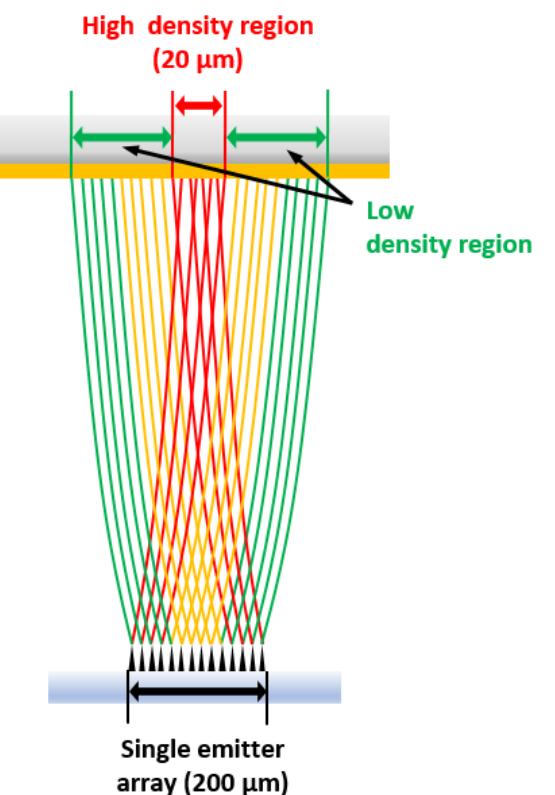
Figure 9. SEM image of Si wafer etched with KOH solution after OTS patterning using a single-island emitter array with 14 × 14 emitter tips.